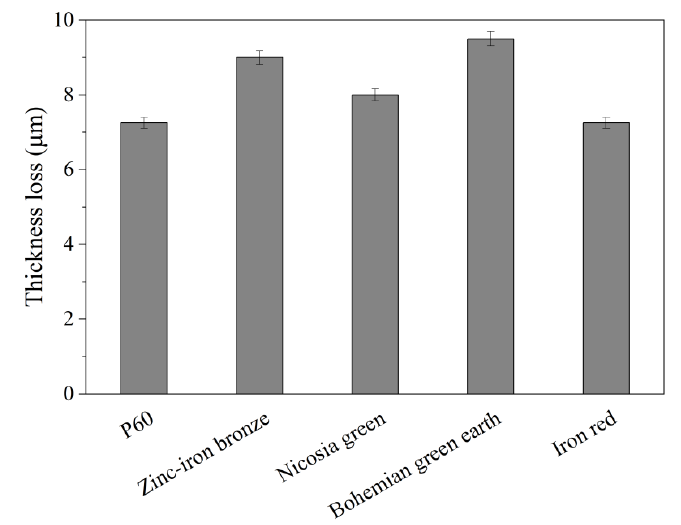
Figure 2. Thickness loss after wet scrub.